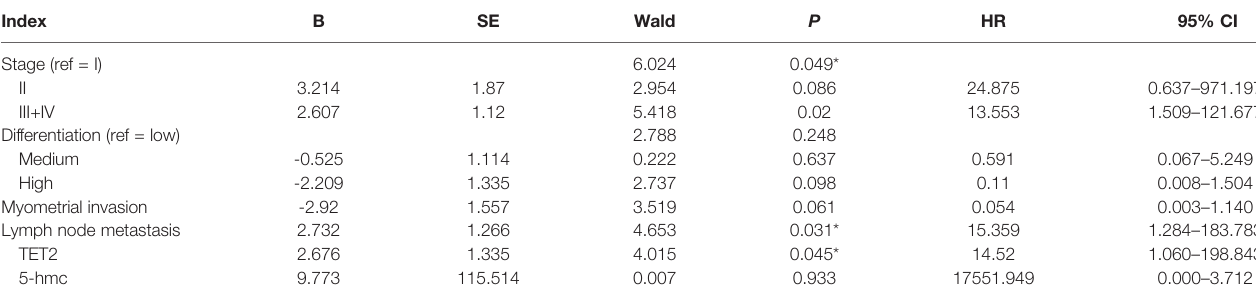
TABLE 2 | Multivariate Cox regression analysis of prognostic factors in patients with EC.